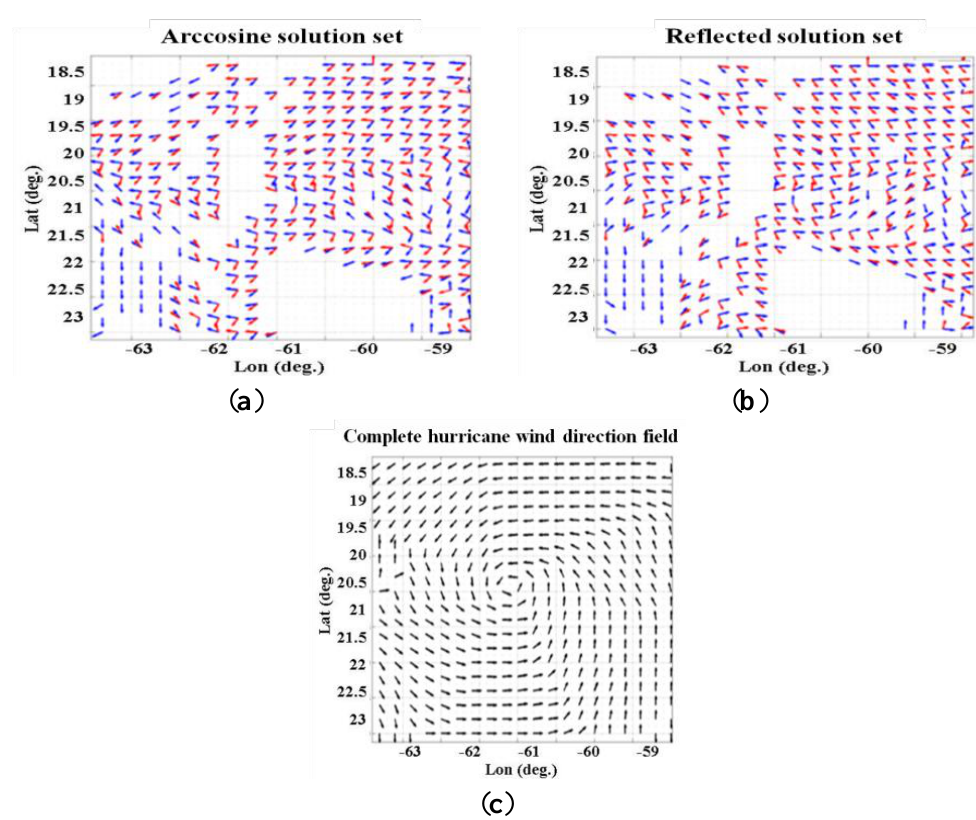
Figure 5. X-Winds wind direction retrievals for Hurricane Fabian (Rev. # 21898): ( a ) is initial wind direction solutions, ( b ) is wind direction mirror image, and ( c ) is the complete hurricane wind direction silhouette after de-aliasing and